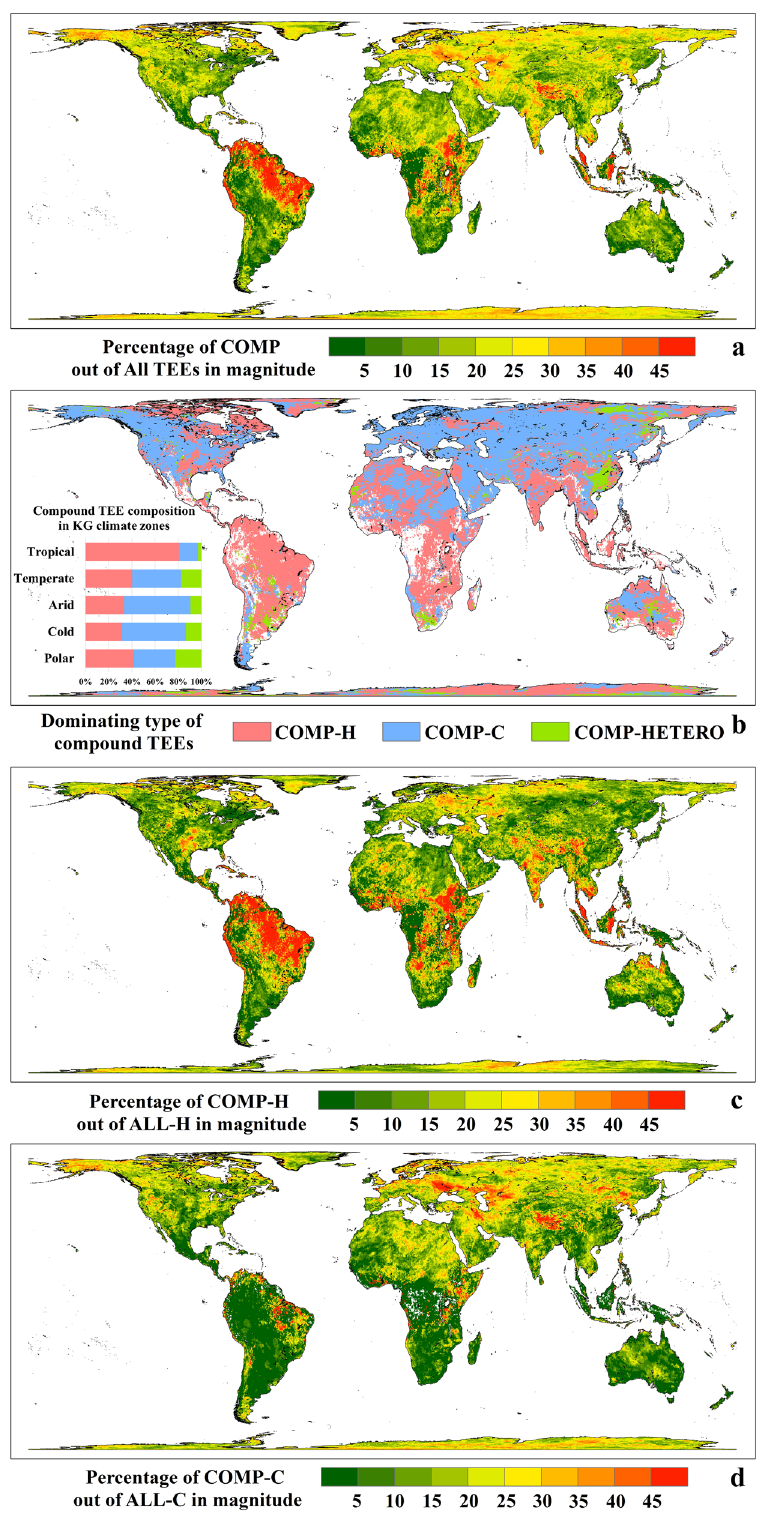
Fig. 6 Global distribution of compound temperature extreme event (TEE) percentages. a Percentage of compound TEEs out of all identi fi ed TEEs in annual cumulative magnitude ( M ). b Compound TEE composition. c Percentage of COMP-H out of ALL-H in M . d Percentage of COMP-C out of ALL-C in M . Figure 2 lists abbreviations of major types of